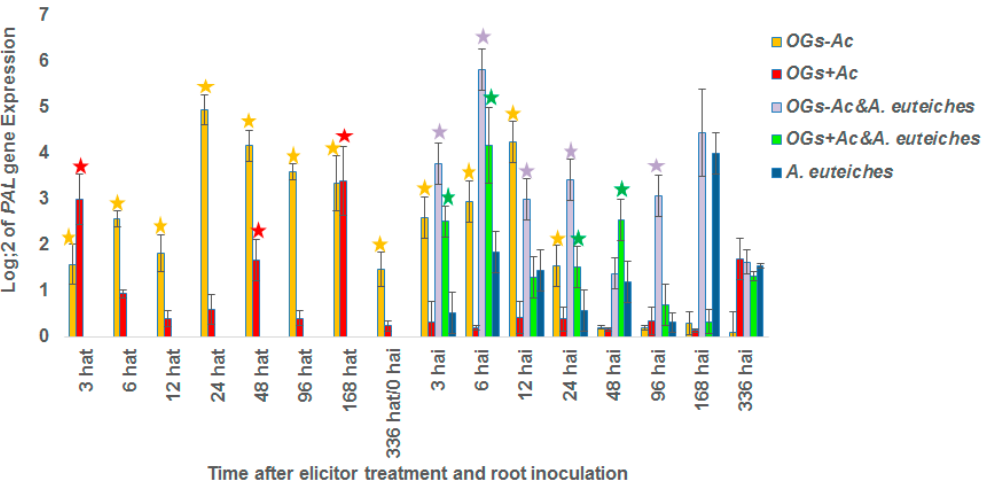
Figure 6. PAL gene expression ratio at 3, 6, 12, 24, 48, 96, 168 and 336 hours after treatment (hat) with water, 80 µg/plant of acetylated oligogalacturonides (OGs + Ac) or 200 µg/plant of nonacetylated OGs (OGs − Ac). The elicitor injections were done two weeks before inoculation (wbi) and two and one wbi for OGs − Ac and OGs + Ac, respectively. After inoculation with 10 5 Aphanomyces euteiches zoospores/plant, PAL gene expression was followed over the same time course (hours after inoculation (hai)). The values shown are means of five repetitions. ☆ Stars indicate gene induction ≥ 2-folds and significant differences between elicitor treatments and inoculated non-treated control according to the Tukey test ( p ≤ 0.05).